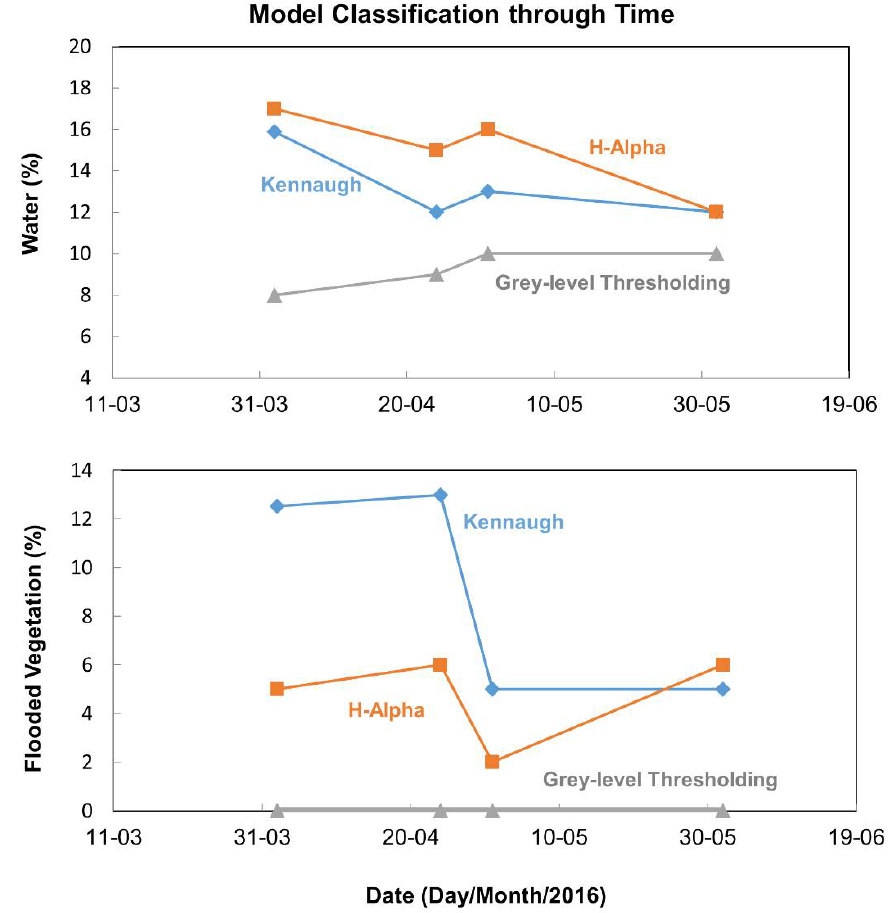
Figure 12. Graphs showing percent of water and percent of flooded vegetation classified through time for each of the classification methods. Lines: Blue diamond—unsupervised k-means classification on Kennaugh Elements, orange square—H-Alpha–Wishart unsupervised classification, and grey triangle—grey-level thresholding.